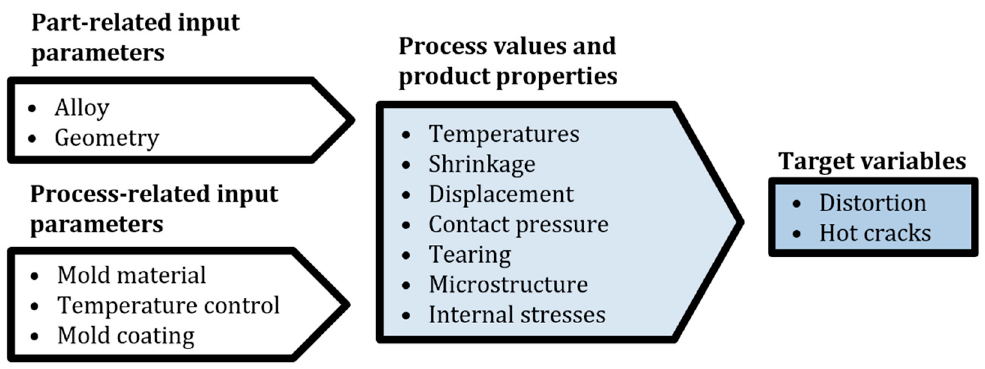
Figure 1. The input parameters, measured variables, and the target variables are shown together.